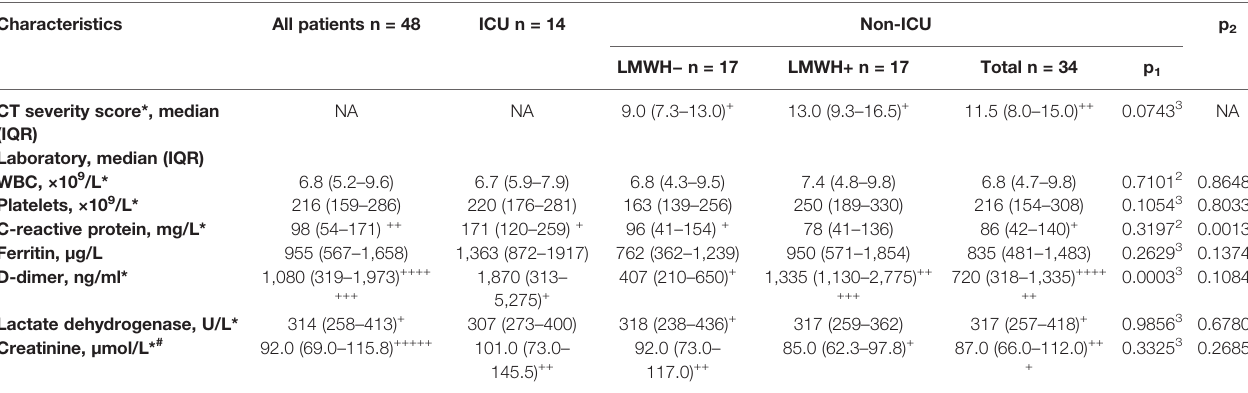
TABLE 2 | Baseline characteristics of COVID-19